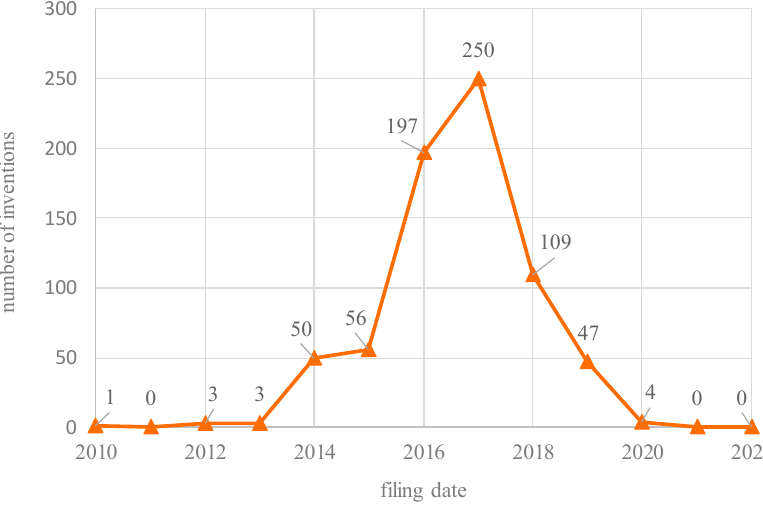
Figure 10. UAV inventions that DJI applied for patents for from 1 January 2010 to 22 June 2022.